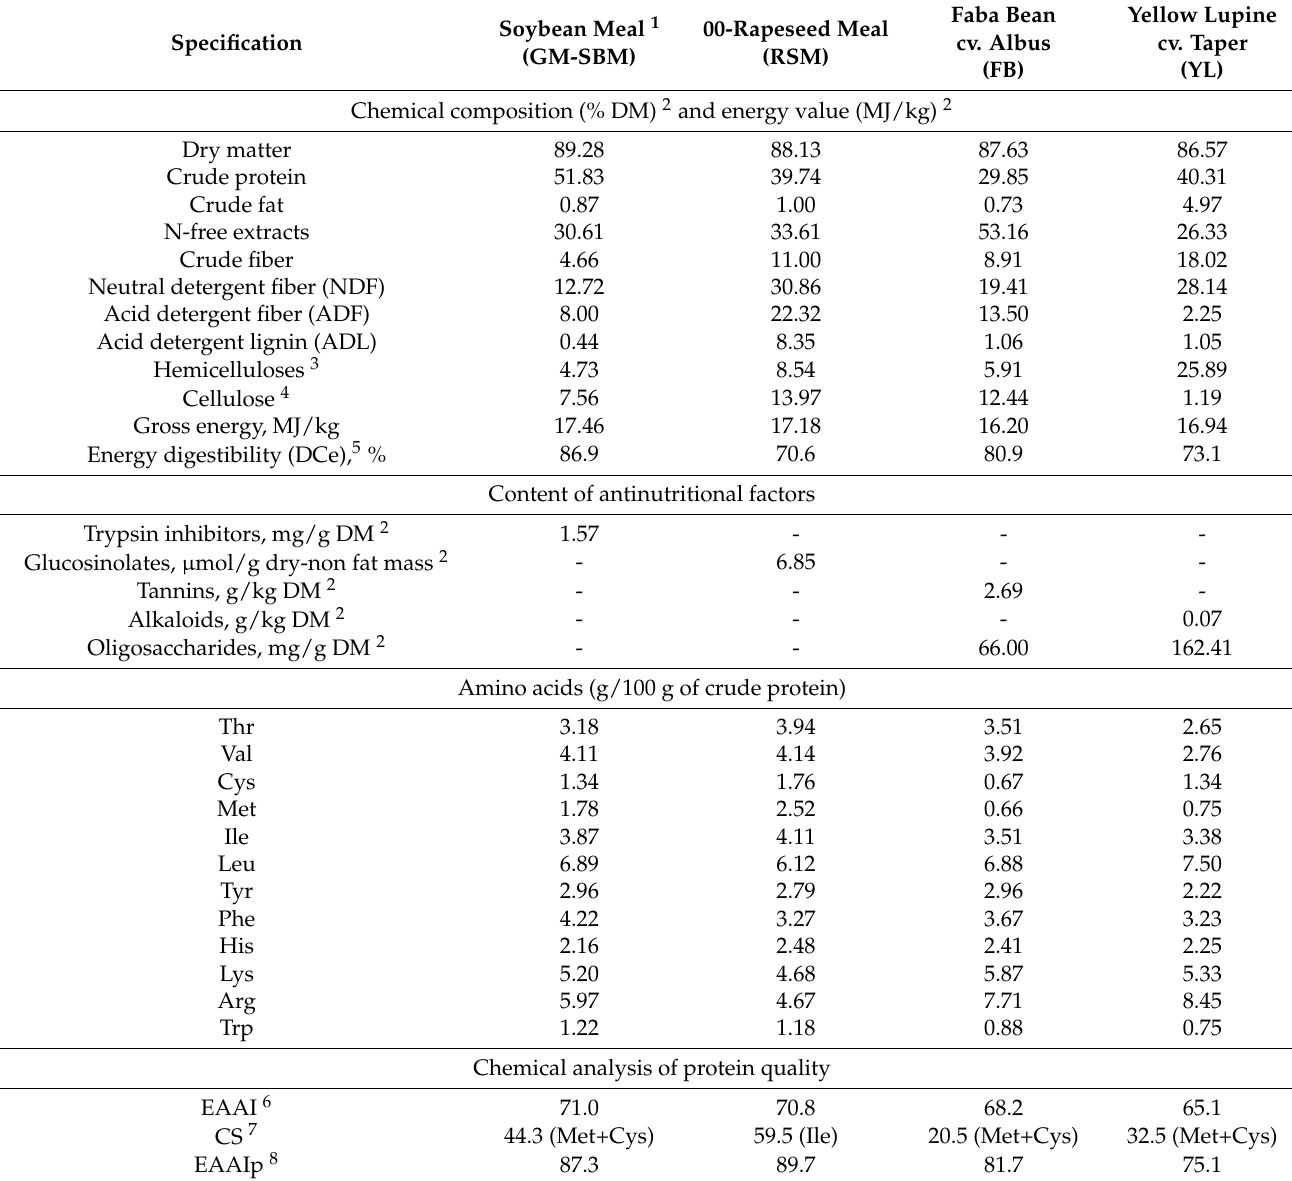
Table 1. Chemical and amino acid composition of protein and the content of antinutritional factors in high-protein feed